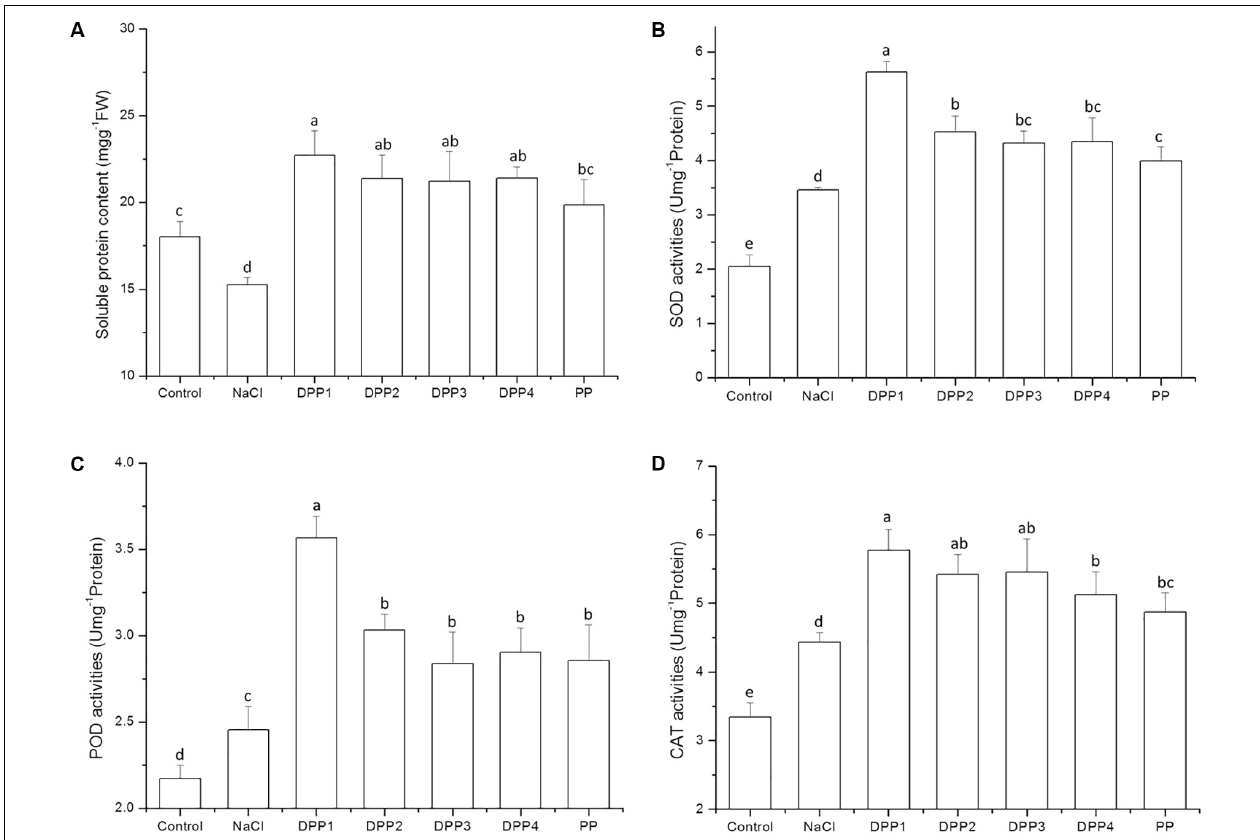
FIGURE 5 | Effect of four degraded (DPP1,2,3,4) and natural polysaccharides (PP) from P. yezoensis on soluble protein contents (A) , SOD (B) , POD (C) , and CAT (D) activities in wheat seedlings. Values are the mean ± SD of three replicates. Different letters indicate significant differences at P <